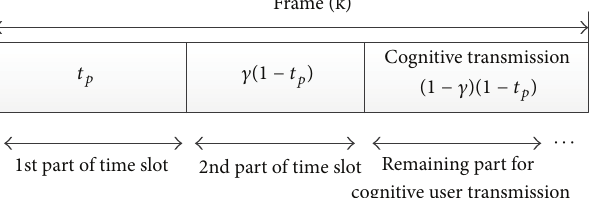
Figure 2: Time slot division for secondary and primary transmis-